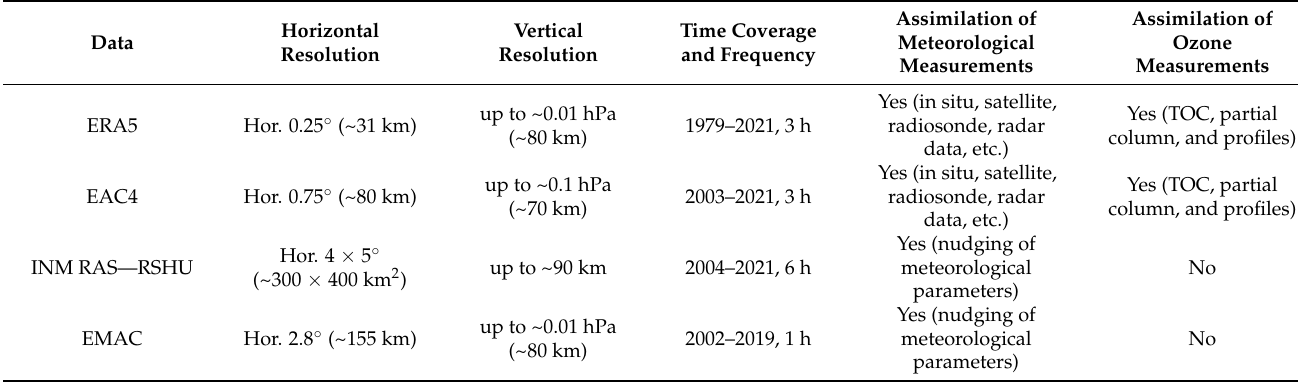
Table 2. Characteristics of the simulated